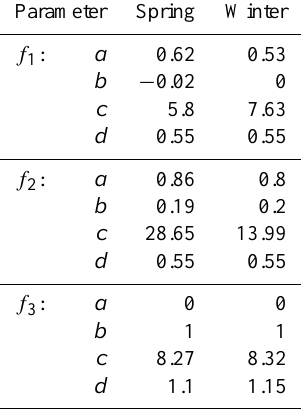
Table A1. The parameters for the factors f 1 , f 2 and f 3 (Eqs. 3–5) for spring and winter wheat.